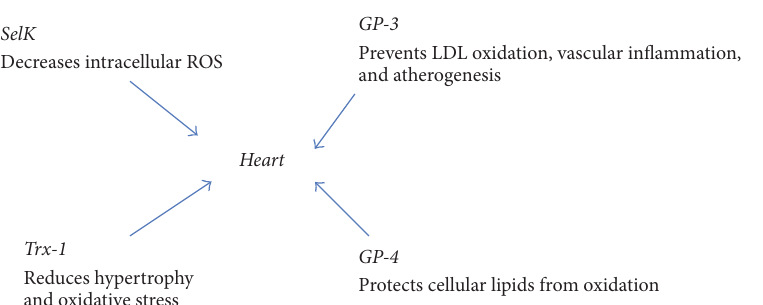
Figure 2: A diagram showing the actions of various selenoproteins on the cardiac myocytes. SelK: selenoprotein K. GP-3: glutathione